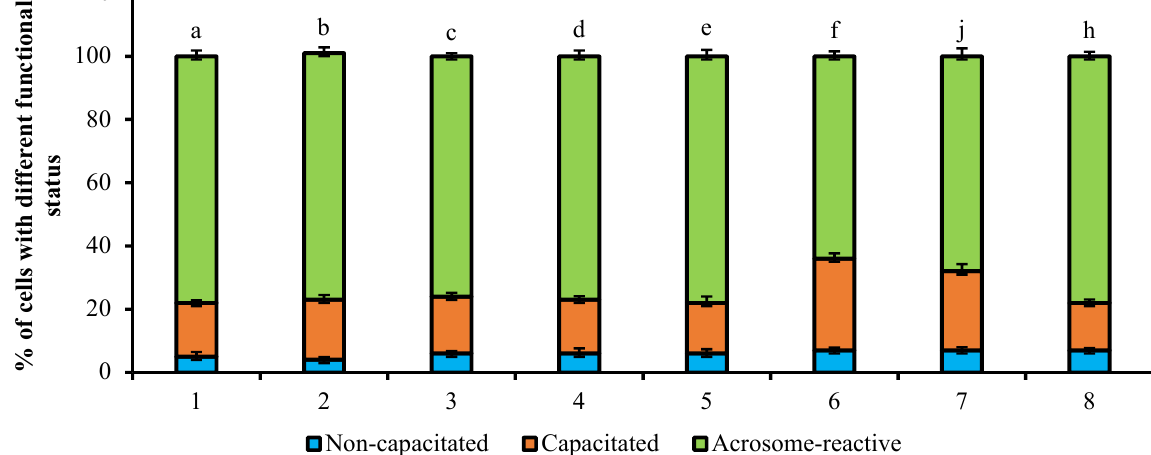
Figure 6. The effect of PRG on the acrosome reaction process activated by 100 µ M dbcAMP (total number of counted cells-6400; number of experiments-4). 1—without any reagents (control); 2—with 100 µ M dbcAMP; 3—with 100 µ M dbcAMP and 10 µ M cytochalasin D; 4—with 100 µ M dbcAMP and 10 µ M nocodazole; 5—with 1 mg/mL PRG (control); 6—with mg/mL PRG, 100 µ M dbcAMP; 7—with 1 mg/mL PRG, 100 µ M dbcAMP and 10 µ M cytochalasin D; 8—with 1 mg/mL PRG, 100 µ M dbcAMP and 10 µ M nocodazole. The differences are significant (percent ratio of capacitated and acrosome-reacted cells) a:f; b:f; c:f; d:f; e:f; h:f at p < 0.001; a:j; b:j; c:j; d:j; e:j; h:j at p < 0.01 (Student’s t -test).